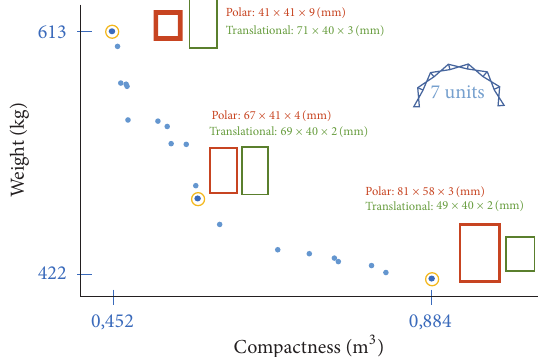
Figure 11: This Pareto front obtained with 160 individuals per generation reached convergence after 23 generations. It shows the design variables of the most extreme optima and of the solution that will be used for further